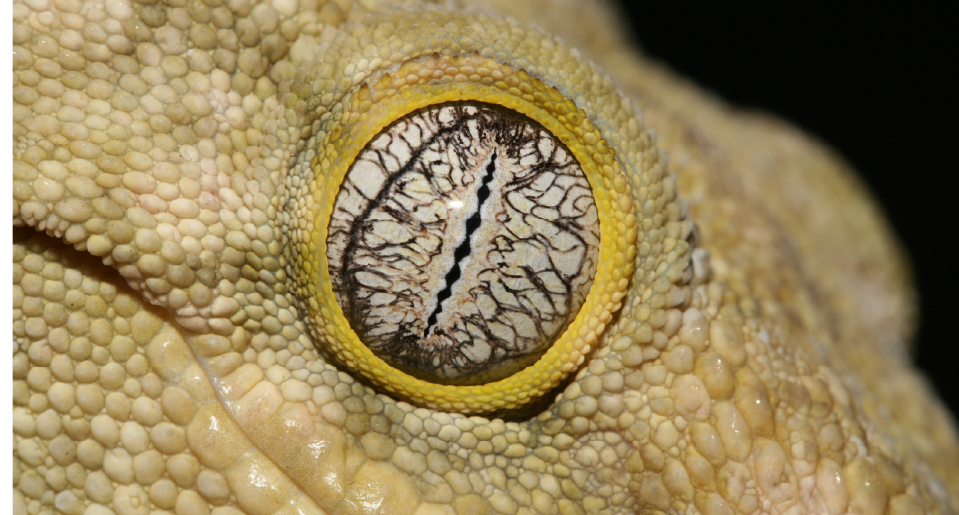
Figure 4. The spectacle in a New Caledonian giant gecko ( Rhacodactylus laechianus ) is bordered by a extra-brillar ring that resembles eyelids but is a separate, fixed structure.